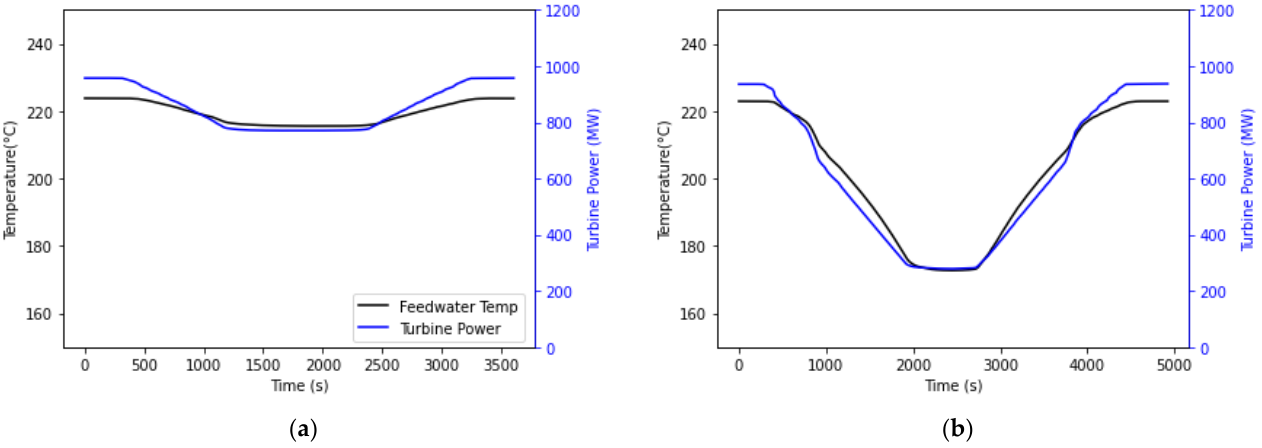
Figure 4. The steam generator feed water temperature and turbine power during the transitions between pure electric power generation and mixed-mode power generation. Results are shown for 15% TPE ( a ) and 50% TPE ( b ).